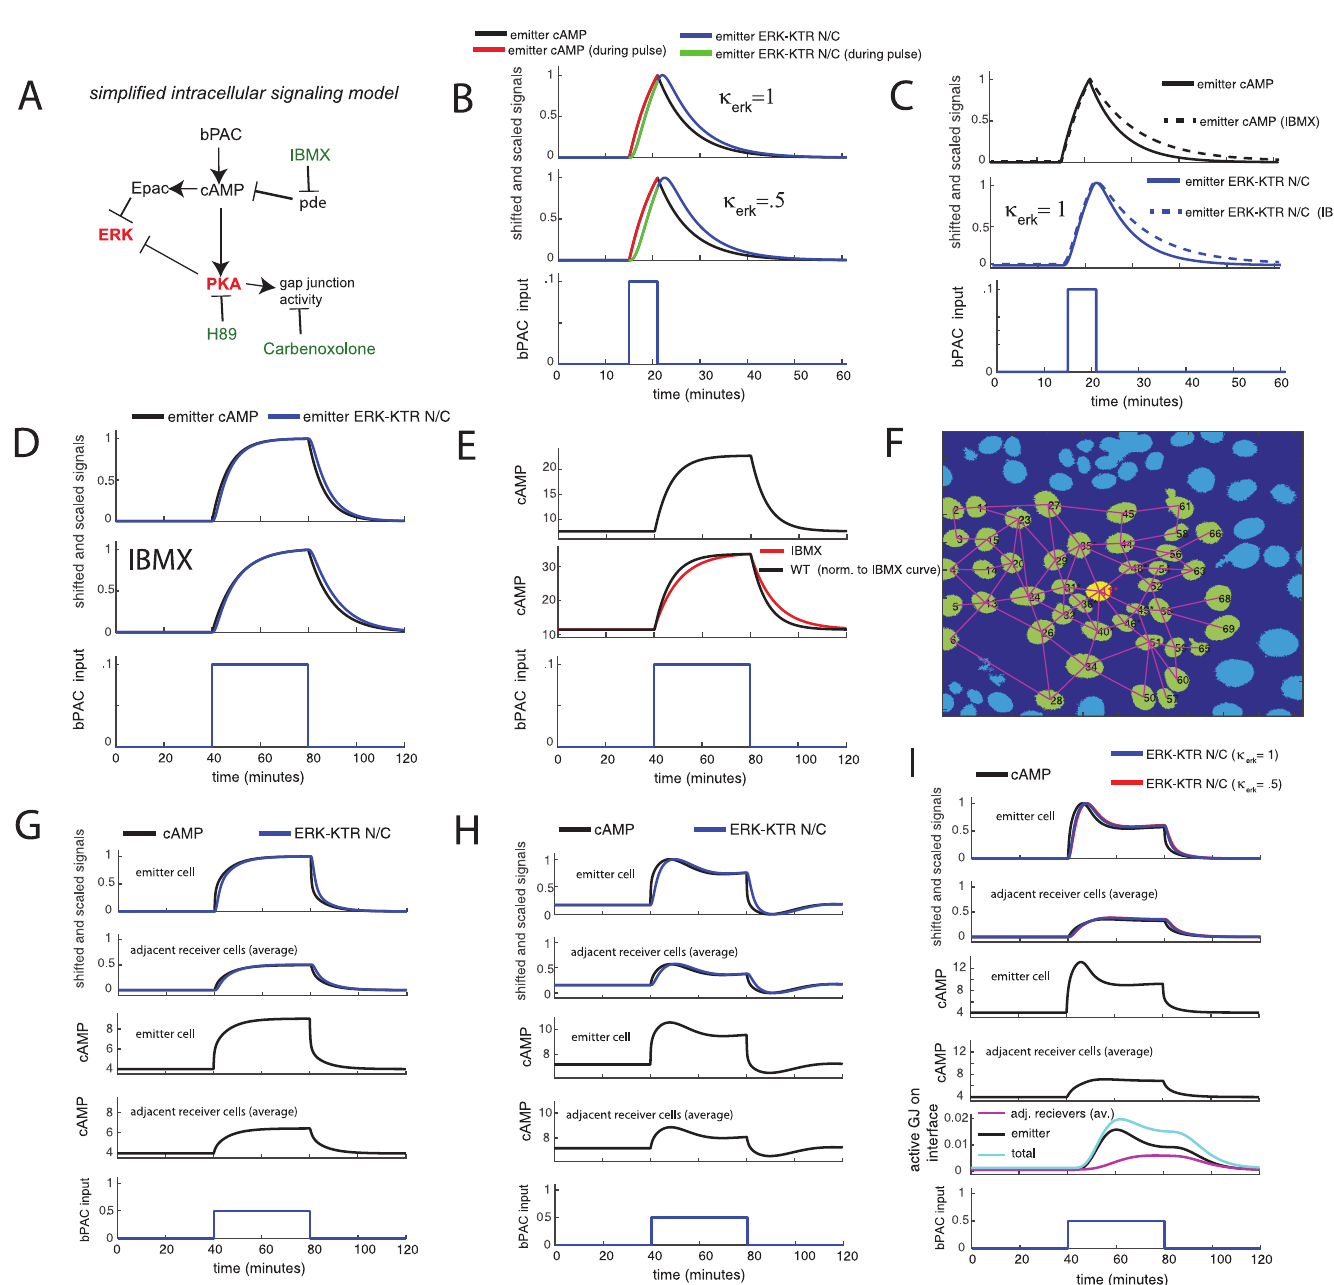
Fig 5. Model requires gap junction regulation with a delay to recapitulate difference in ERK-KTR N/C signals between emitter and adjacent receiver cells. (A) Illustration of simplified intracellular pathway. (B-E) Modeling results for simplified intracellular pathway with no feedbacks in an all-emitter monolayer. Model is fitted to ERK-KTR N/C data for 6 minute bPAC input pulses applied to an all-emitter monolayer (S1(B) Fig, IBMX, population average). ERK-KTR N/C and cAMP signals shifted to zero and scaled for comparison, with the peak of the emitter signal at 1 and minimum at zero. (B) ERK-KTR N/C signal and predicted cAMP signal driven by 6 minute bPAC input pulse. We present results for two values of the deactivation rate of ERK γ using the expression κ where κ is a scaling factor and γ is a erk erk γ erk erk erk fitted deactivation rate. Top plot: fitted model ( κ = 1). Middle plot: same fitted model except for a slower ERK deactivation rate reduced by a factor of 2 ( κ = .5). (C) erk erk Fitted model results ( κ erk = 1) for ERK-KTR N/C signal and predicted cAMP signal, with and without IBMX. (D) Predicted 40 minute bPAC input pulse driven ERK-KTR N/C and cAMP signals (with and without IBMX). Signals shifted to zero and normalized for comparison. (E) Modeled cAMP signal (top plot), and with PDE inhibitor (IBMX, middle plot). Same signals as in (D) but not zero shifted and normalized. (F) Multicellular system to be modeled with 1 emitter (yellow nucleus, red label) and receiver cells (light green nuclei, black label). Lines connecting nuclei represent direct cell-cell communication through gap-junctions. (G-I) Single-emitter- cluster modeling using system in (F): For top two plots, the ERK-KTR N/C and cAMP signals are shifted to zero and scaled for comparison, with the peak of the emitter signal at 1 and the minimum at zero. The receiver signals are multiplied by the same scaling factor as the emitter to maintain the same relative amplitudes (proportionally). (G) Results for the simplified intracellular pathway with constant gap junctional permeability. (H) Results for the intracellular PKA feedback model